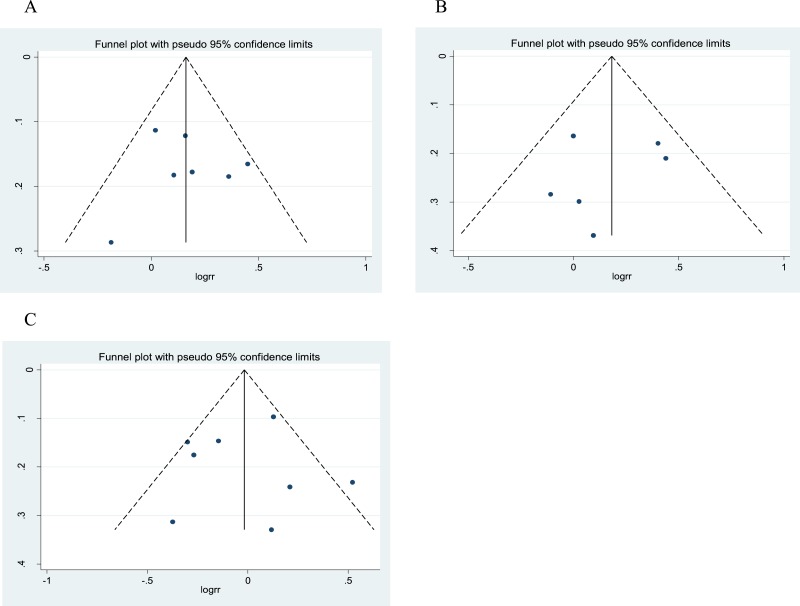
Funnel plot for publication bias analysis of Gemin4 rs7813 (A), rs2740348 (B) and Gemin3 rs197412 (C).